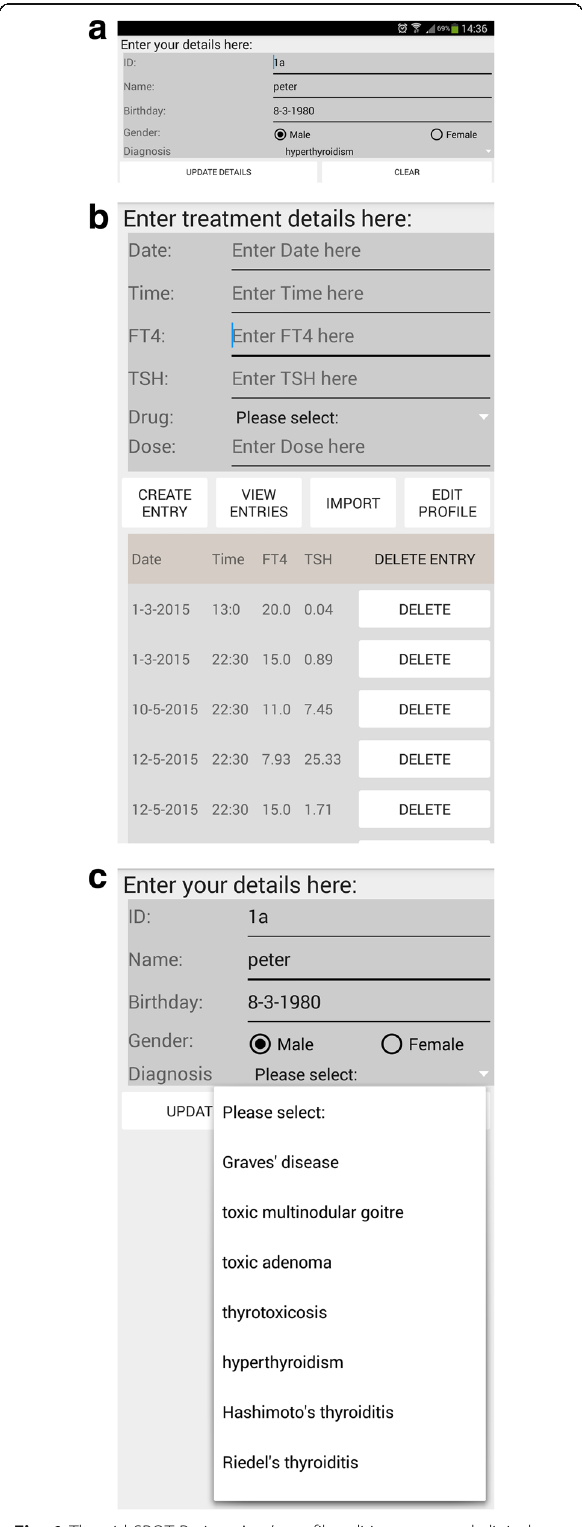
Fig. 1 Thyroid-SPOT Patient App ’ s profile editing page and